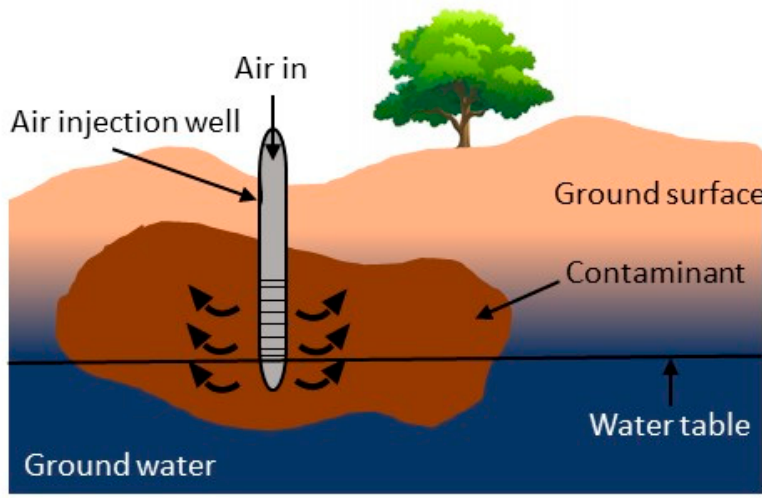
Figure 6. Typical biosparging system (adapted from [3]).